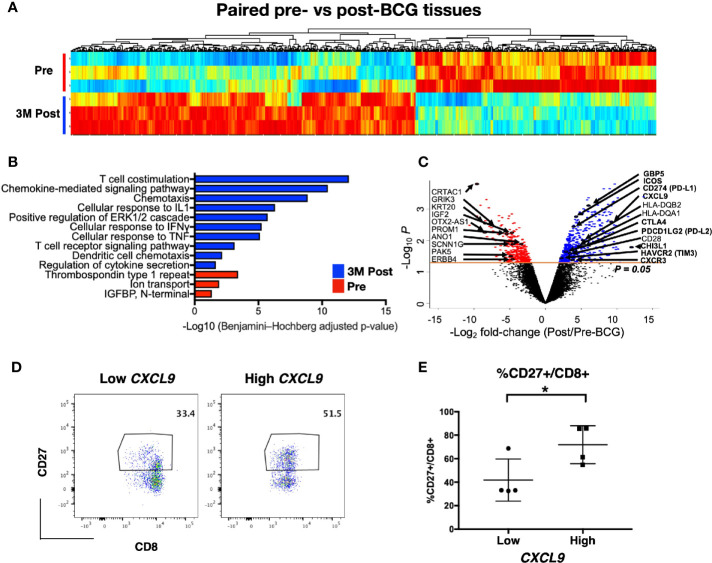
Post-Bacillus Calmette-Guerin (BCG) treated tissues show upregulation in genes involved in multiple immune activation pathways. (A) Heatmap showing all differentially expressed genes (DEGs) from matched tissues between Pre and 3M Post-BCG time points (n=3 from each group). (B) Functional pathways annotated by DAVID pathway enrichment analysis of the genes enriched in Pre (red bar) or 3M Post-BCG time points (blue bar). (C) Volcano plot showing DEGs in the Pre and 3M Post-BCG tissues. Genes enriched in Post-BCG time point are colored in blue while genes enriched in Pre time point are colored in red. Selected genes are highlighted. The orange line denotes the p value of 0.05. (D) Representative dot plots showing CD8+CD27+ cells gated from CD3+CD56- T cells of isolated cells from tissues with low (patient 16 pre-NT) and high (patient 2 post-NT) CXCL9 genes, respectively. Median value for CXCL9 genes was used as the cutoff point for dichotomisation into two groups. (E) Proportion of CD27 expressing CD8 T cells from tissues with low CXCL9 group (n=4), and high CXCL9 group (n=4), respectively. Graph shows mean with standard deviation. *p<0.05 by Mann-Whitney U test.